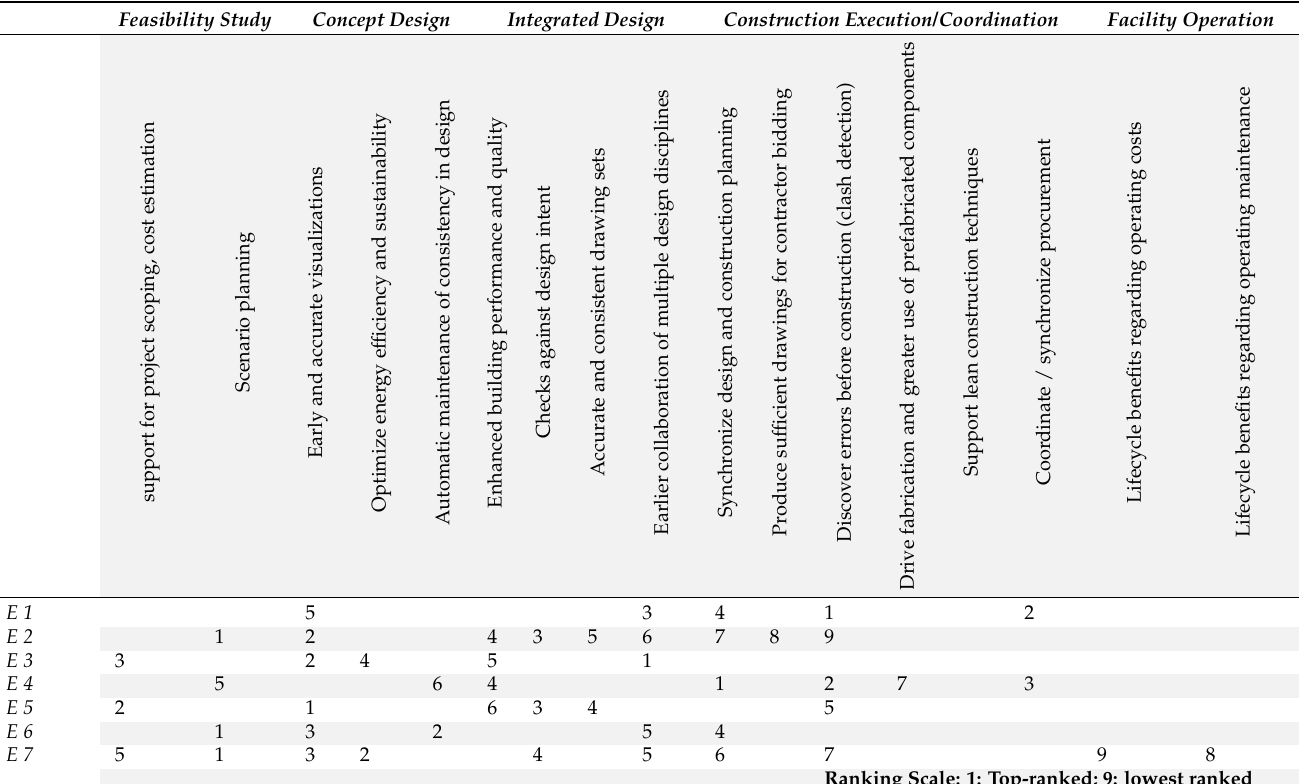
Ranking Scale: 1: Top-ranked; 9: lowest